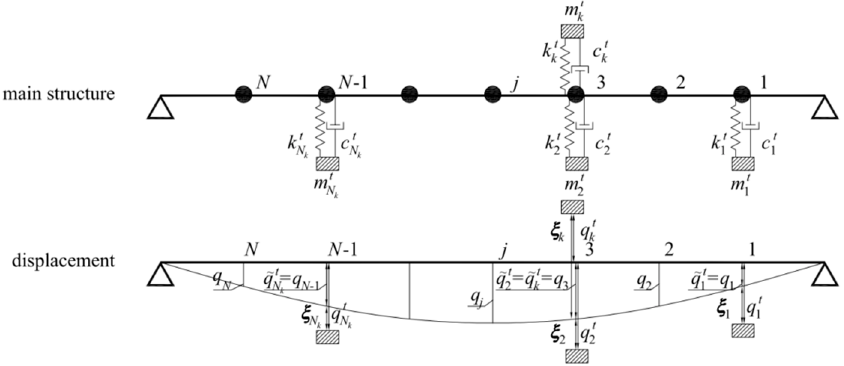
Figure 2. General arrangement diagram for tuned mass dampers (TMDs) within the main struc- ture.